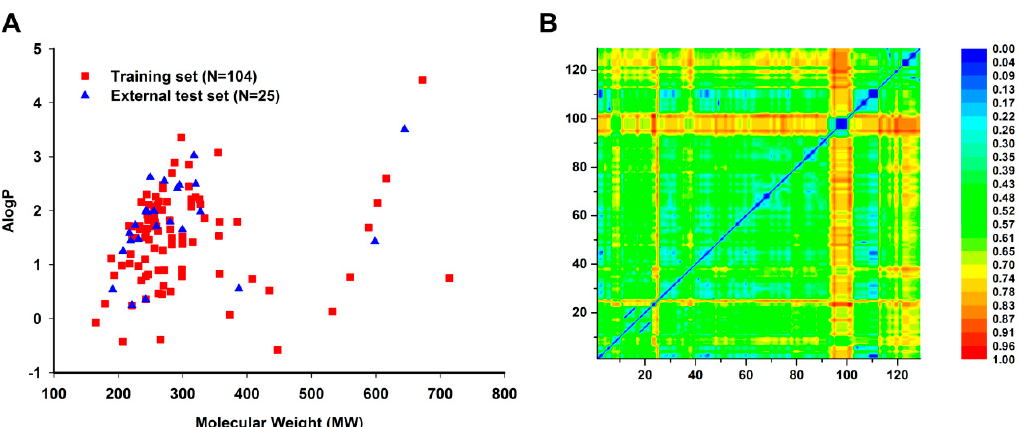
Figure 4. Chemical diversity distribution of the training set (N = 104 compounds), external test set (N = 25 compounds). ( A ) Chemical space was analyzed using the molecule weight (MW) and Ghose-Crippen LogKow (ALogP) of each set in the database. N represents the number of compounds in each data set. ( B ) Heat map of molecular similarity plotted by Euclidian distance metrics for the training and external test sets. Euclidian distance metrics was calculated by MACCS keys fingerprint and processed by normalization.